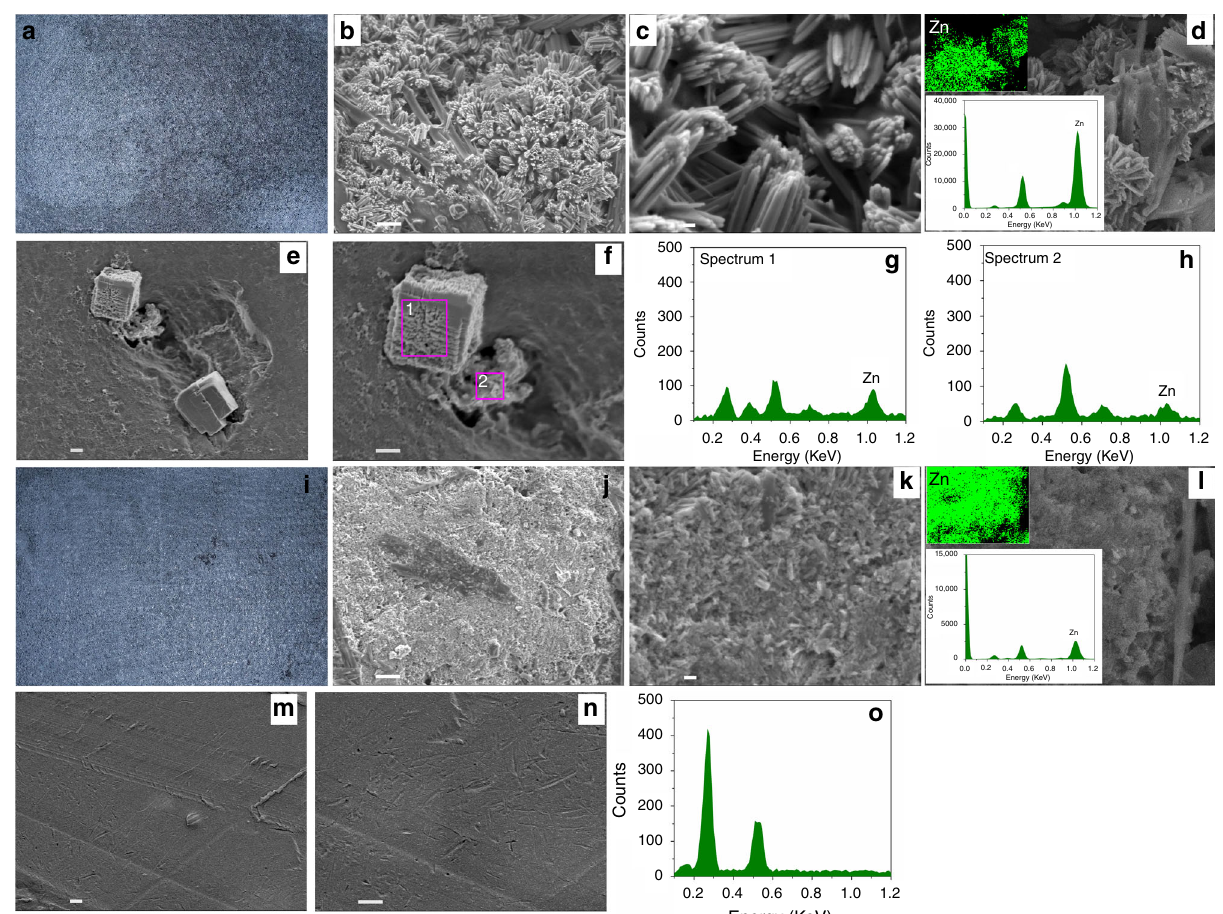
Fig. 4 Morphologies of zinc metal (dendrite) and membrane surface. a Optical image of the negative electrode at the end of 53rd charge for the alkaline zinc – iron fl ow battery assembled with a P0 membrane. b SEM image of zinc metal (dendrite) in the carbon felt in panel a . c Magni fi ed SEM image of zinc metal (dendrite) in panel b . d EDS spectrum and EDS mapping of the zinc metal (dendrite) in the corresponding SEM image. e The surface morphology of P0 membrane at the end of 65th discharge. f Magni fi ed surface morphology of P0 in panel e . g , h Corresponding EDS spectrums of the lumps in P0 membrane marked by mauve rectangle in panel f , where zinc metal (dendrite) was pierced into P0 membrane and retained in the membrane even at the end of discharge. i Optical image of the negative electrode at the end of 183rd charge for the alkaline zinc – iron fl ow battery assembled with a P20 membrane. j SEM image of zinc metal in the carbon felt in panel i . k Magni fi ed SEM image of zinc metal in panel j . l EDS spectrum and EDS mapping of the zinc metal in the corresponding SEM image. m The surface morphology of P20 membrane at the end of 186th discharge. n Magni fi ed surface morphology of P20 in panel m . o Corresponding EDS spectra of P20 membrane in panel n , where no zinc metal (dendrite) can be found at the end of discharge. The battery is charged and discharged at 80 mA cm − 2 . P20 is a negatively charged nanoporous membrane, where the sulfonated poly(ether ether